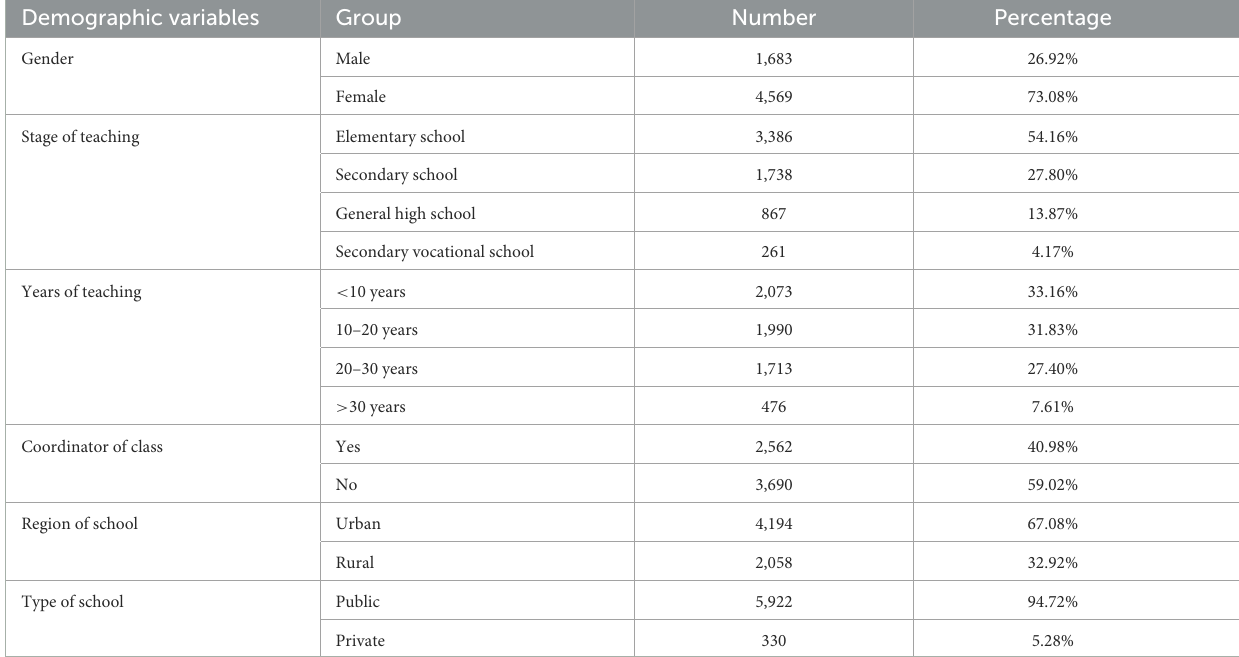
TABLE 1 Demographic characteristics of the survey sample in Phase 1.